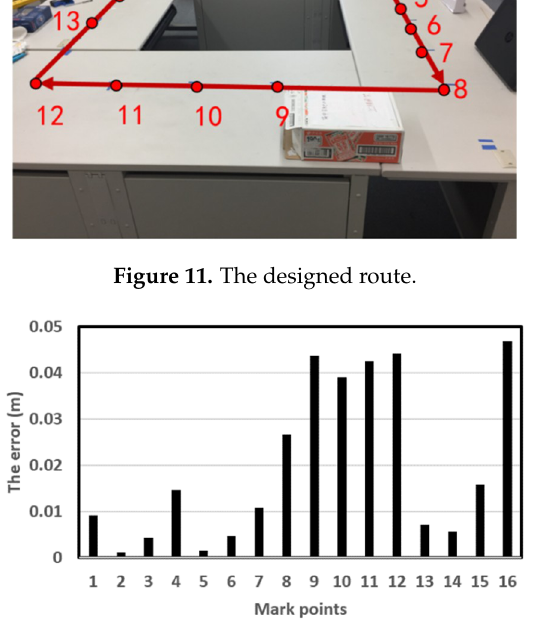
Figure 12. The errors of marked points.